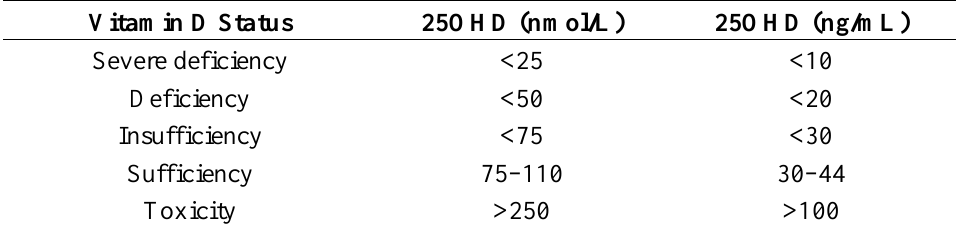
Table 2. Cut-offs in vitamin D status according to the Endocrine Society